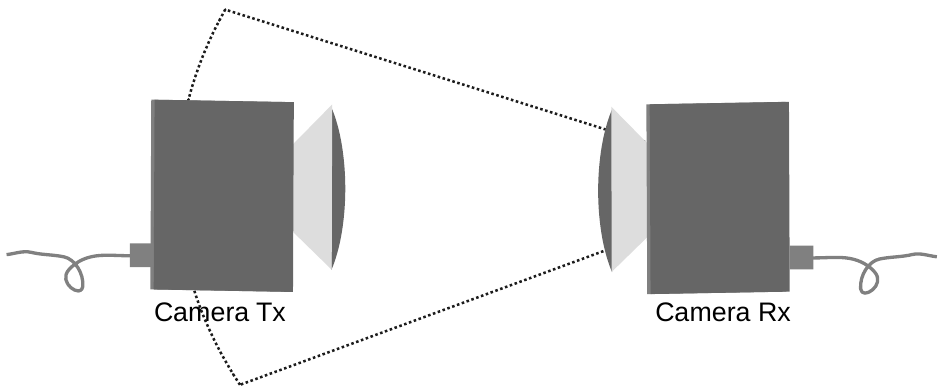
Figure 2. The concept of the covert channel using two thermal cameras, one for data transmission (Tx) and one for data reception (Rx).